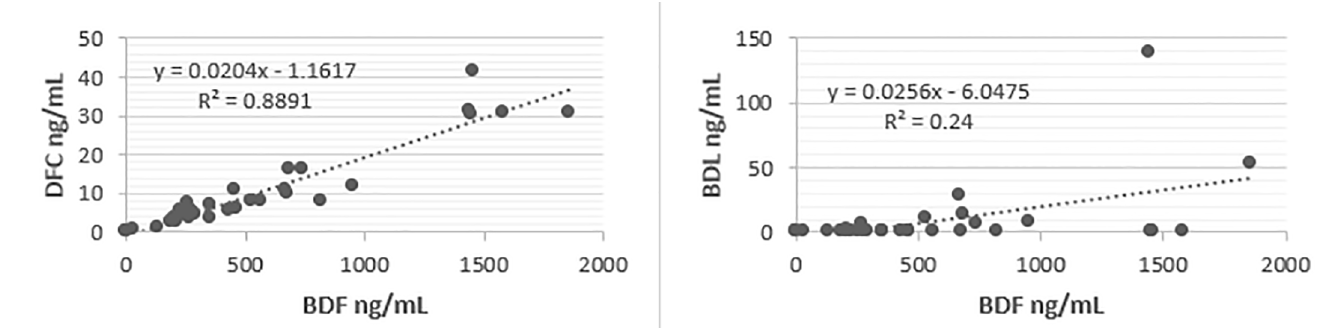
Figure 3. Left: Serum brodifacoum levels plotted on X axis; serum difenacoum levels plotted on Y axis. Linear relationship indicates likely co-contaminant. Right: Serum brodifacoum levels plotted on X axis; serum bromadiolone levels plotted on Y axis. Bromadiolone levels were around 4% of brodifacoum levels, suggesting this is a minor metabolite or a minor co-contaminant. ng, nanogram; mL, milliliter.